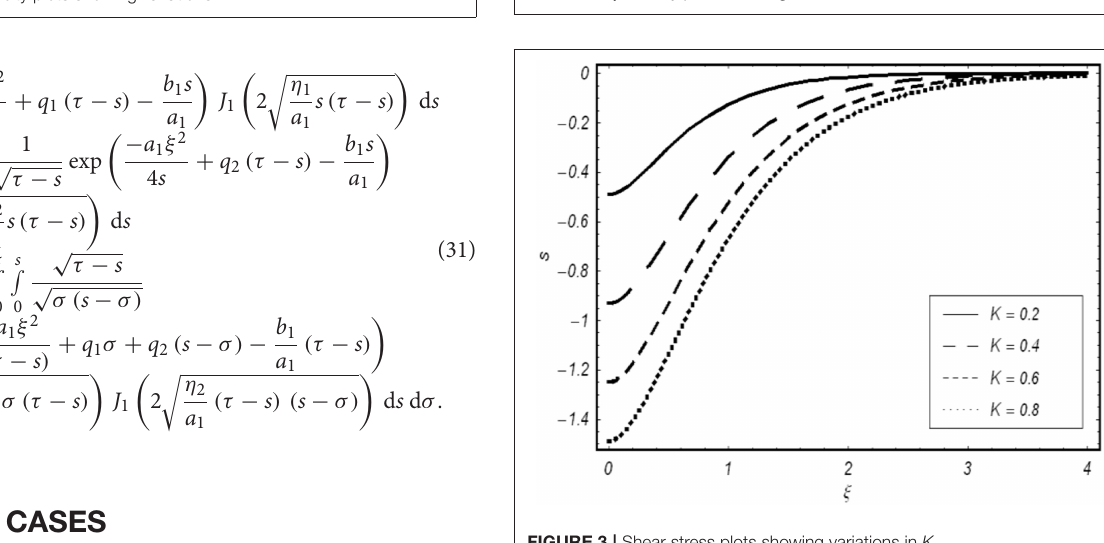
FIGURE 1 | Velocity plots showing variations in K . FIGURE 2 | Velocity plots showing variations in M .